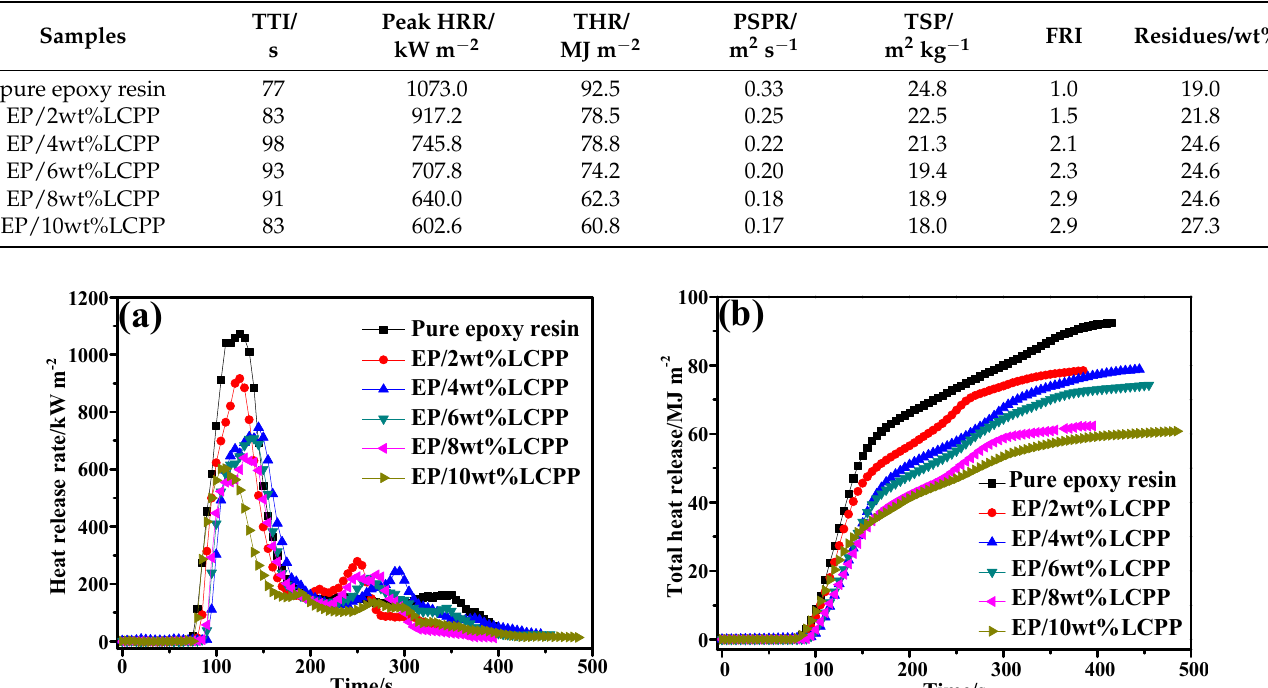
Table 3. Combustion parameters obtained from the cone calorimeter test.